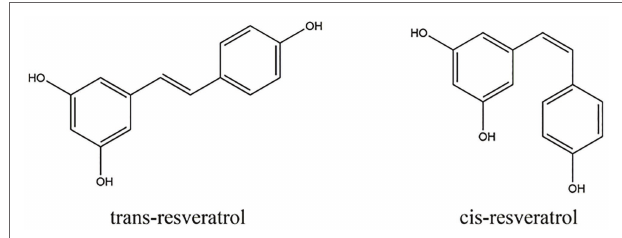
FIGURE 1 | Chemical structures of trans -resveratrol and cis